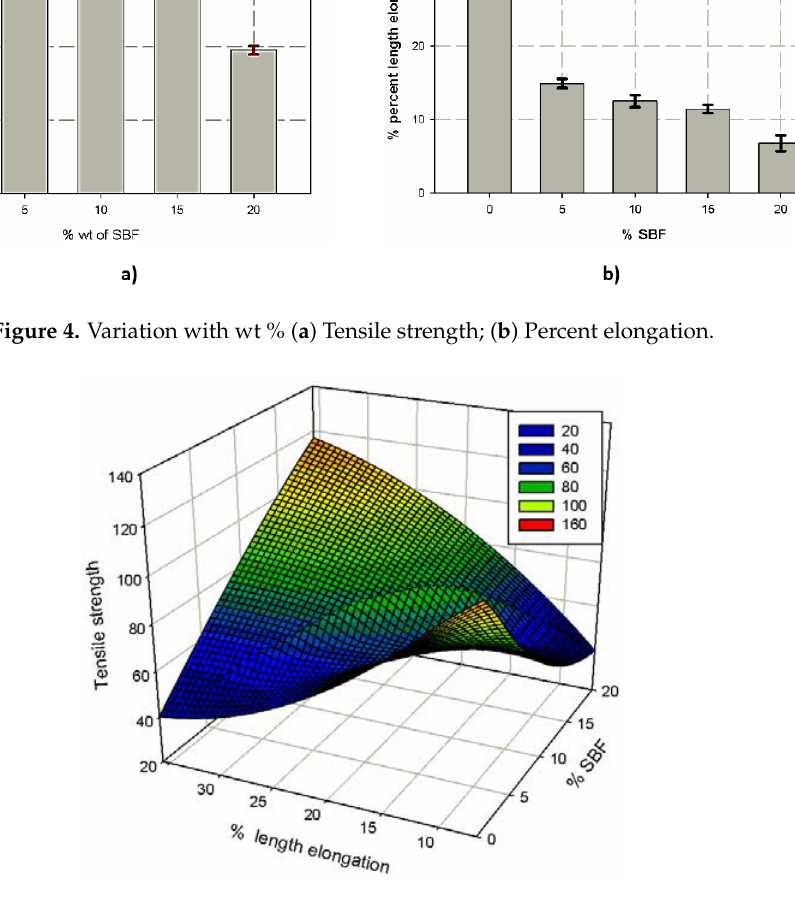
Figure 5. A 3D curve relating the tensile test results with wt % of SBF reinforcement.